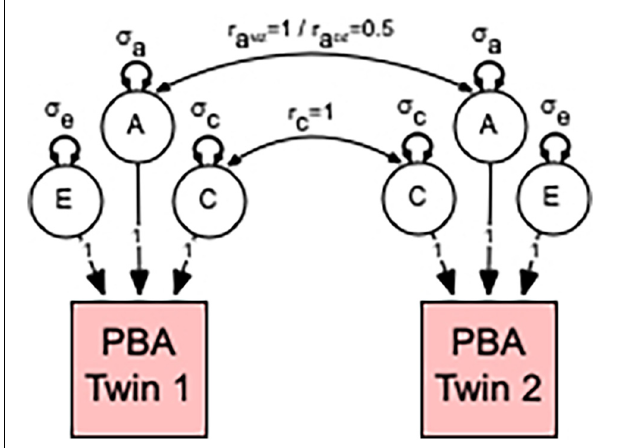
FIGURE 1 | Univariate model to estimate the relative contribution of genetic and environmental influences in predicted brain ageing (PBA). Individual differences in PBA are decomposed into three sources of variation: additive genetic (A); common or shared environmental influences (C); and unshared or random environmental influences as well as measurement error (E). This decomposition is achieved by specifying the expected genetic and environmental correlations between monozygotic (MZ) and dizygotic (DZ) twin pairs. MZ twin pairs are genetically identical, whereas DZ twin pairs share, on average, half of their genes. Therefore, the MZ and DZ twin pair correlations (r aMZ and r aDZ ) for additive genetic effects are fixed to 1.0 and 0.5, respectively. This model also assumes that shared environmental effects are equally correlated (r c = 1) in MZ and DZ twin pairs. Non-shared environmental influences are by definition uncorrelated within twin pairs (r e = 0). Note that our method of estimating the relative contribution of genetic and environmental influences in PBA proceeds by estimating the additive genetic ( σ a ), shared environmental ( σ c ), and non-shared environmental ( σ e ) variances for the A, C, and E latent factors. The size or contribution of these σ e , σ c , and σ e variance components to the phenotype are assumed to be equal within twin